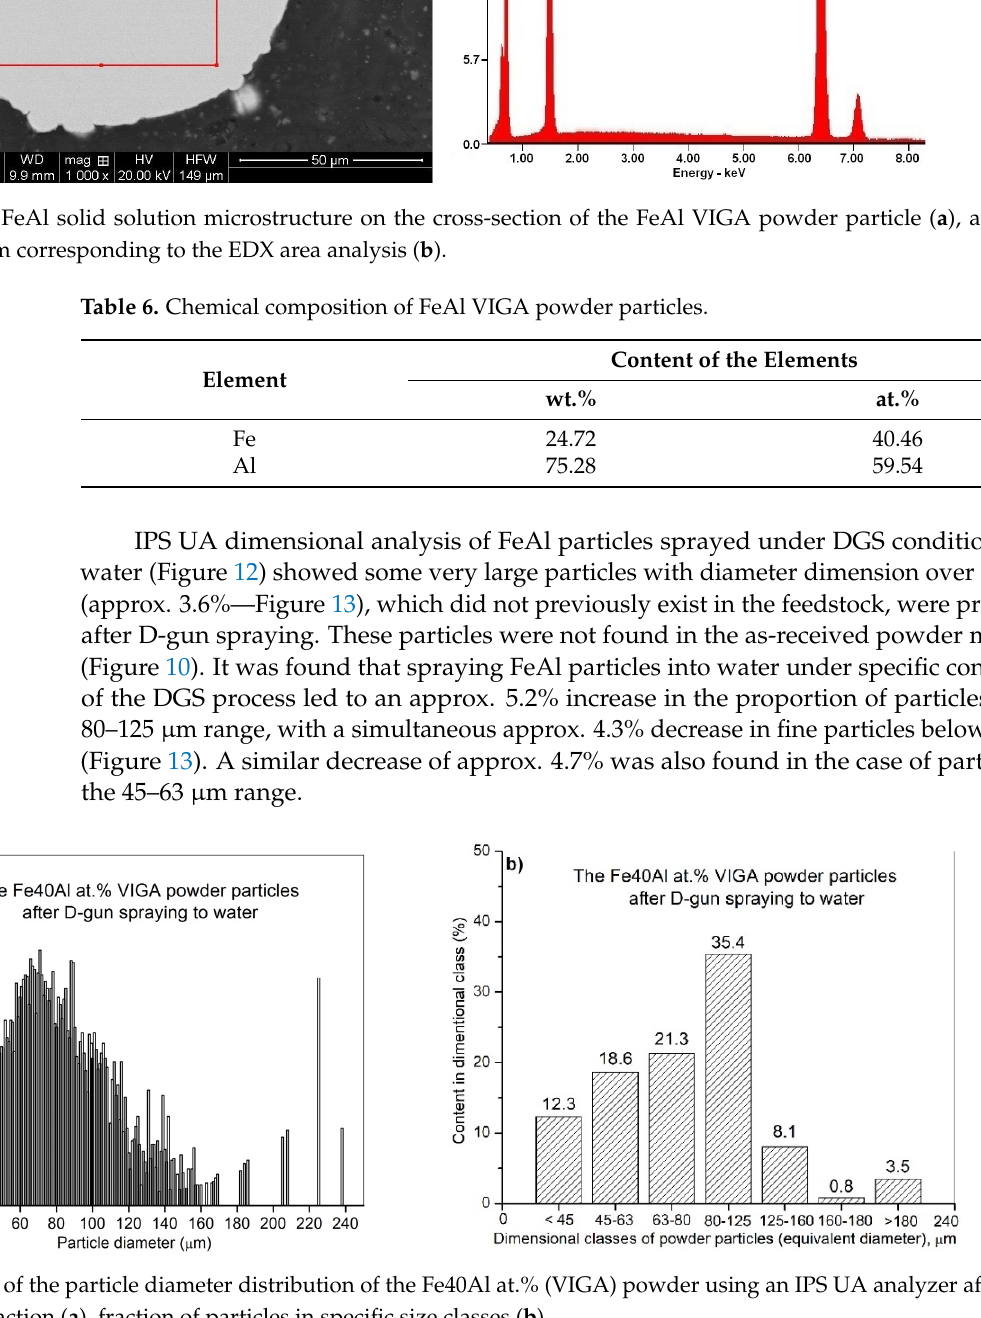
Figure 13. Percentage change in volume fraction in a specific size class of FeAl powder particles sprayed with D-gun into water as compared to as-received FeAl powder. The SEM/EDS observations reveal, that the change in particle size distribution could be related to the melting of powder particles below 60 μ m, which form larger grain clus- ters upon impact with the water surface (Figure 14). Created agglomerates were formed by the welding of molten fine particles dispersed in a gas stream (Figure 14a). As a result of phase transformations of the FeAl phase melting in the stream of hot gases in the DGS process, larger-size FeAl powders, melted on the surface, can also be welded (Figure 14b,c). This may explain the formation of about 3.6% of FeAl powder particles of diameter above 180 μ m, which were not observed in the powder charge introduced into the “Perun- S” detonation gun feeder. The chemical composition analysis from the surface of five randomly selected grain clusters, formed from melted particles of DGS powder sprayed into water (Figure 14a), presents a significant increase of aluminium and oxygen contents, which due to the lack of SEM/EDS calibration should be treated as a qualitative—semi-quantitative analysis (Ta- ble 7).